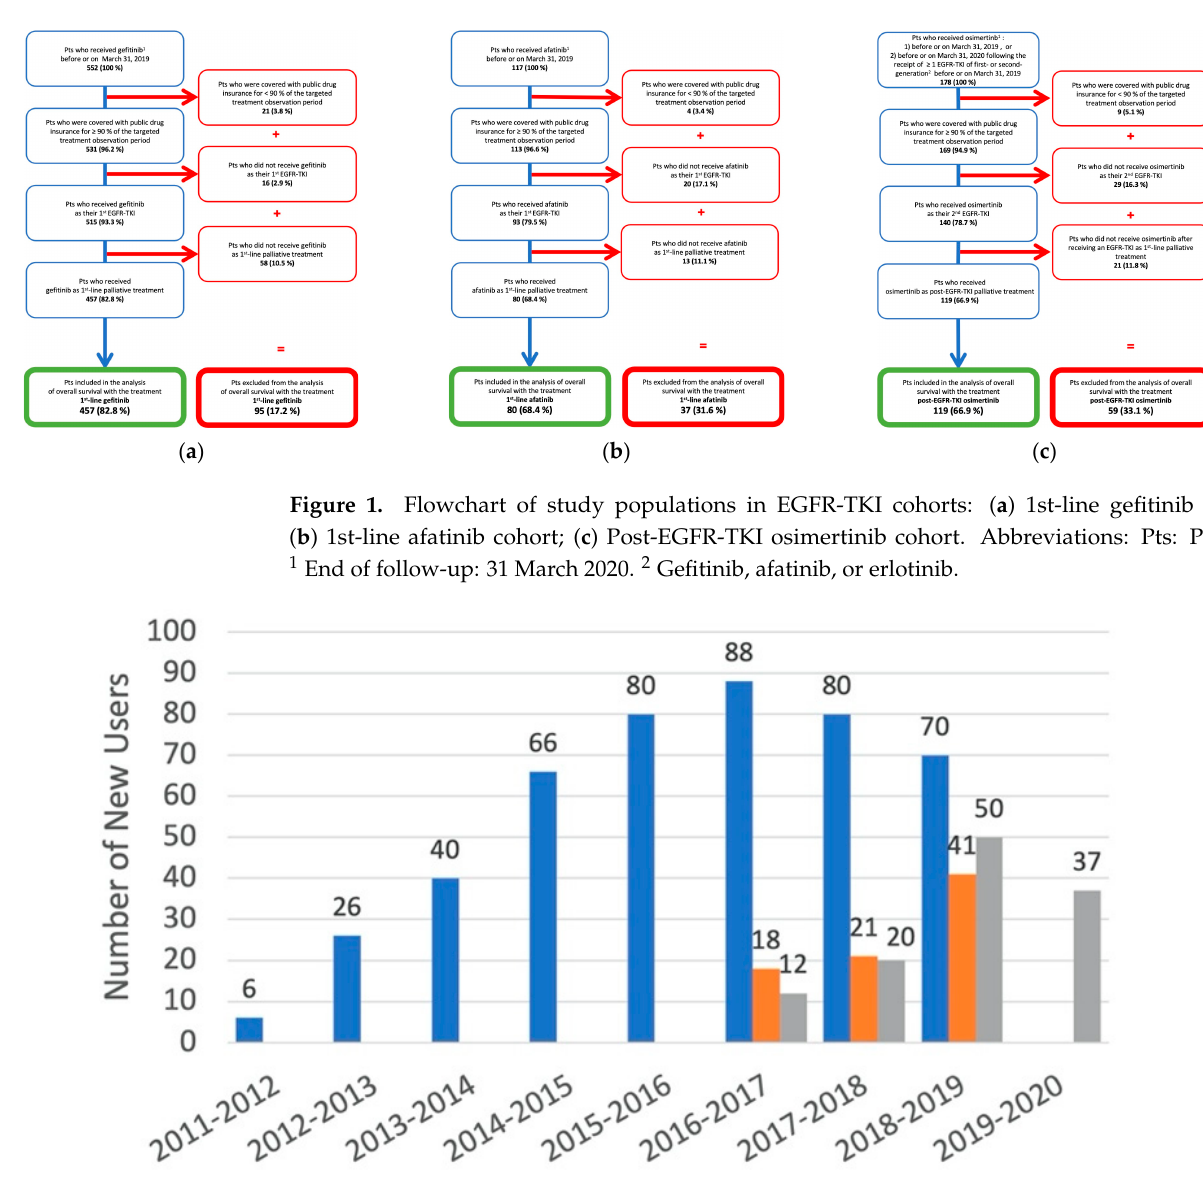
Figure 2. Distribution of New Users of Each EGFR ‐ TKI for Specific Indications, by Fiscal Year.